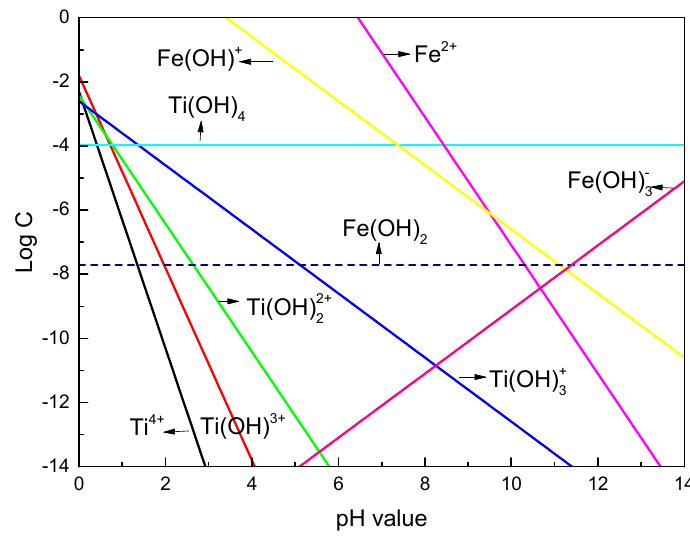
Figure 7. The speciation of the ilmenite surface as a function of solution pH (modified from [12]).